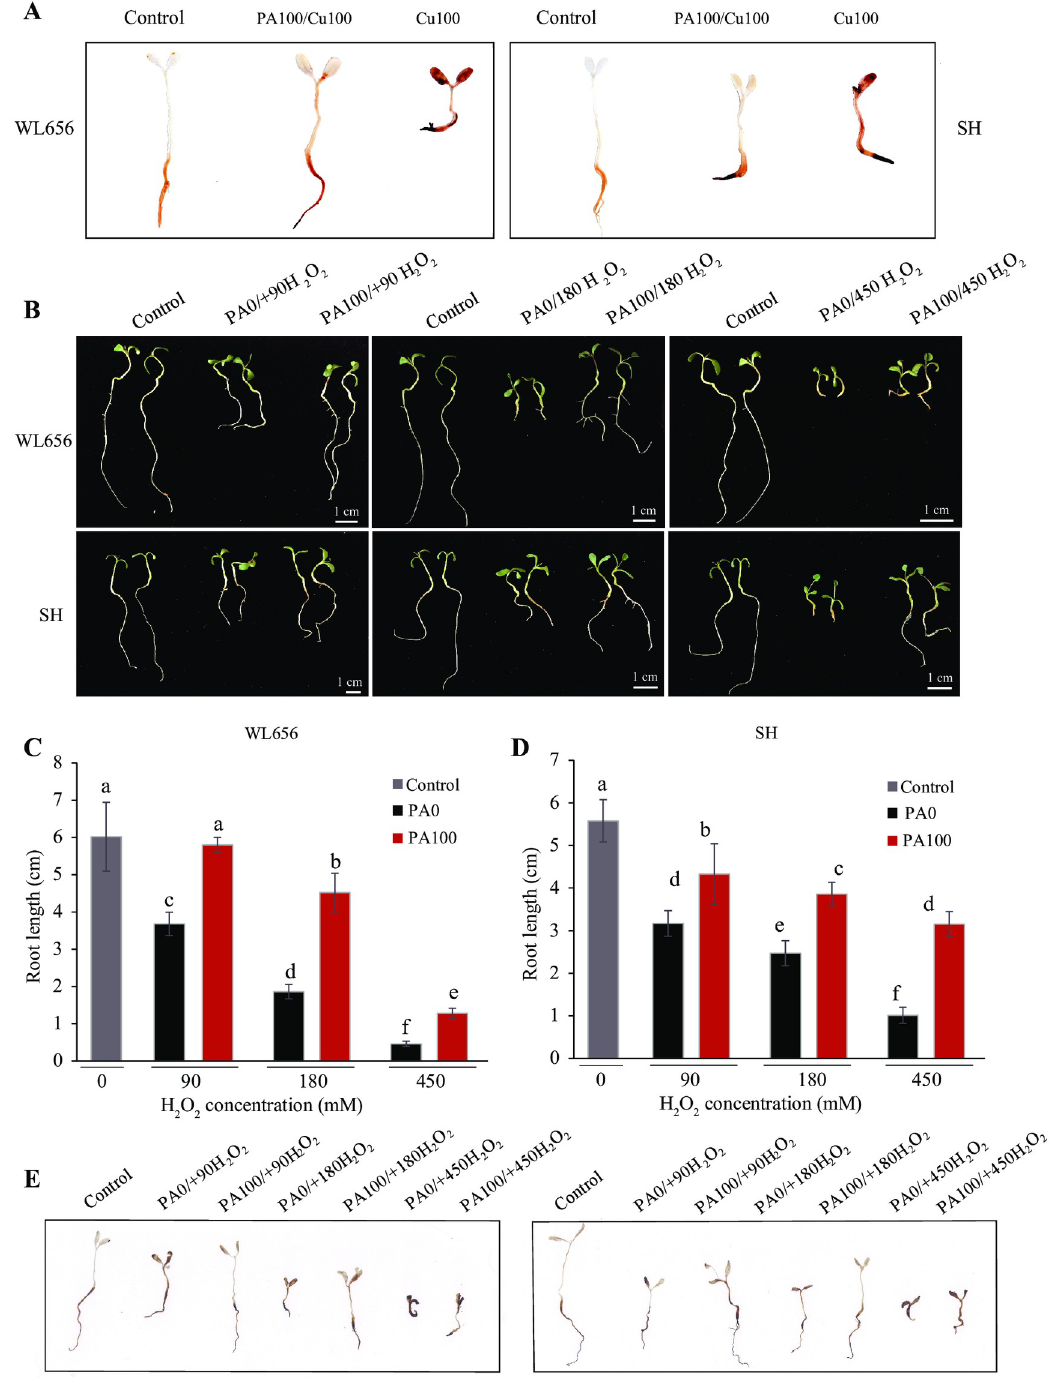
Fig 2. Proanthocyanidins (PAs) improved alfalfa seedling growth under oxidative stress. (A) Histochemical staining with DAB under Cu stress pretreated with PAs. (B) The phenotype of seedlings after 8 d of excess H 2 O 2 treatment or pretreated with PAs. PAs increased the root length of WL656 (C) and SH (D) under excess H 2 O 2 treatment. (E) Histochemical staining with DAB under different concentration of H 2 O 2 or pretreated with PAs. PA0: 0 mg L -1 PAs pretreatment, PA100: 100 mg L -1 PAs pretreatment, Cu100: 100 mg L -1 CuSO 4 •5H 2 O, 90 H 2 O 2 : 90 mM H 2 O 2 , 180 H 2 O 2 : 180 mM H 2 O 2 , 450 H 2 O 2 : 450 mM H 2 O 2 . Means ± SE of three biological replicates. Significant differences ( p � 0.05) were denoted by different lowercase